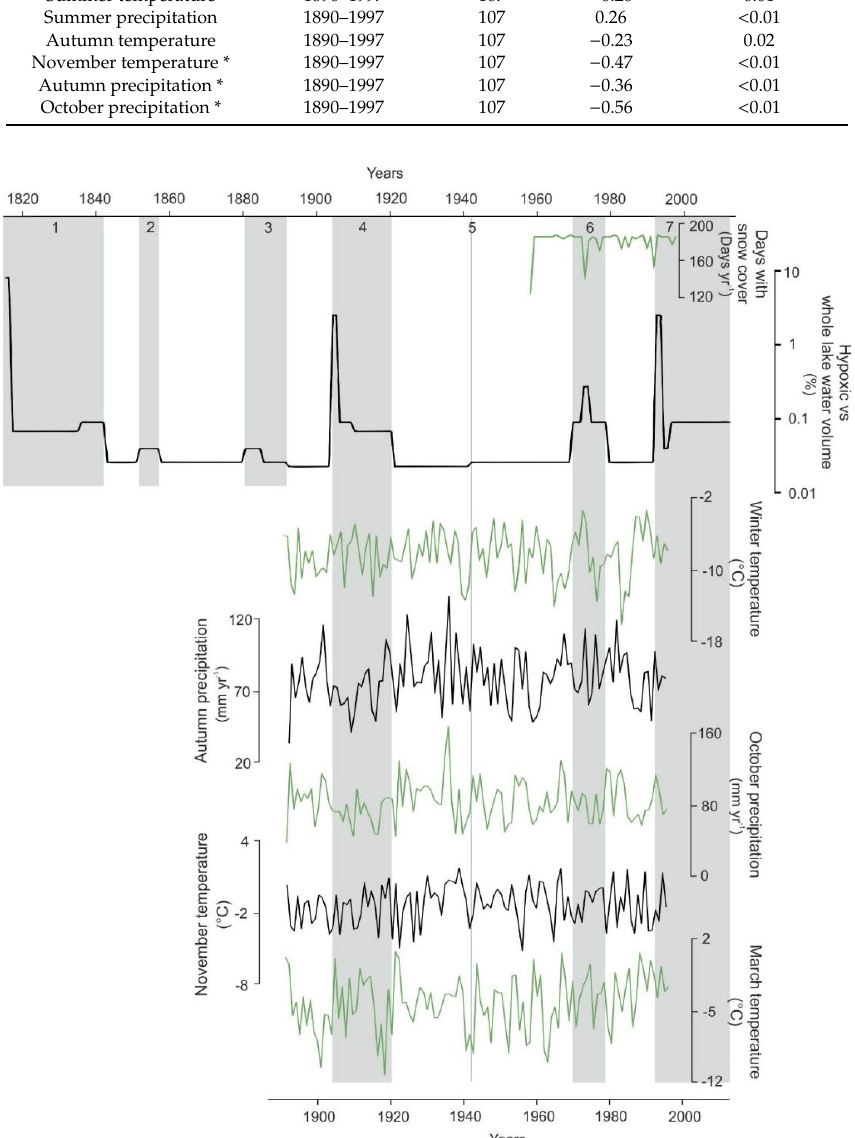
Figure 7. Hypoxic water volume from 1815–2014 compared to variations in climate variables. Hypoxia volume is displayed on a logarithmic scale. Climate variables with correlation coefficients > 0.3 and p-values < 0.05 are shown. Hypoxia periods 1–7 are marked with grey bars.